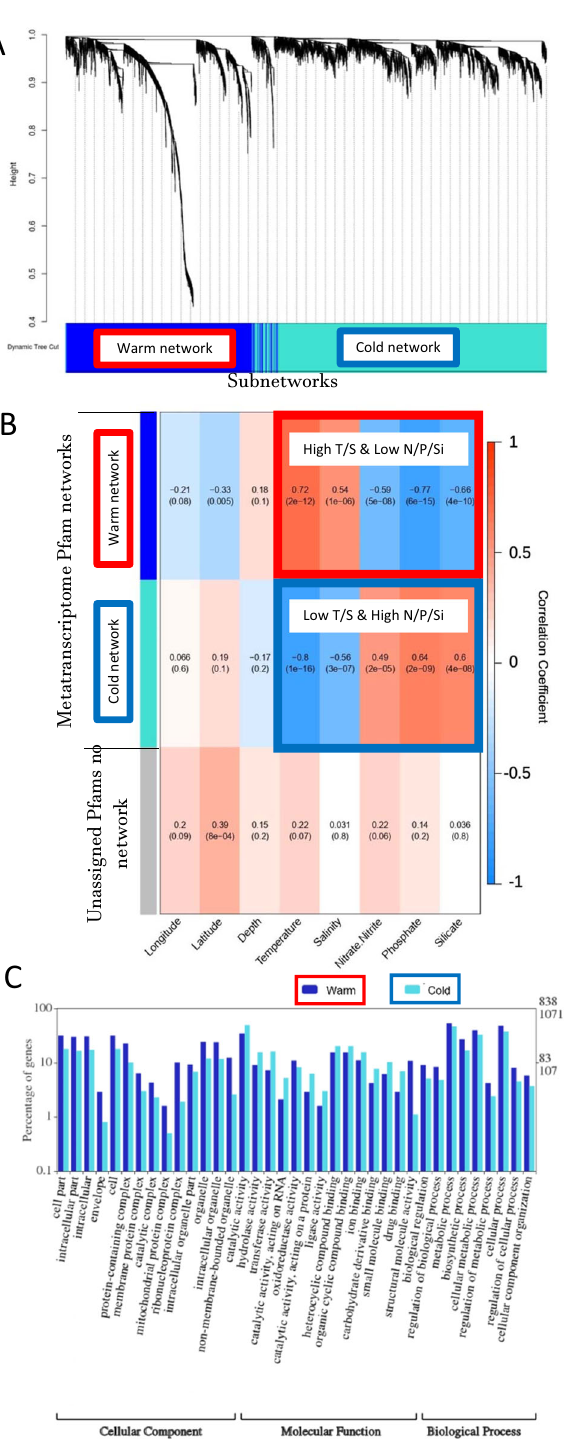
(Supplementary Figs. 4, 5). Only 22% of the 18S dataset could be assigned to taxa at the levels of species (Supplementary Figs. 4a, 6c), while for the 16S dataset, 47% could be assigned to taxa at the levels of genus (Supplementary Fig. 4b, Supplementary Fig. 6d).